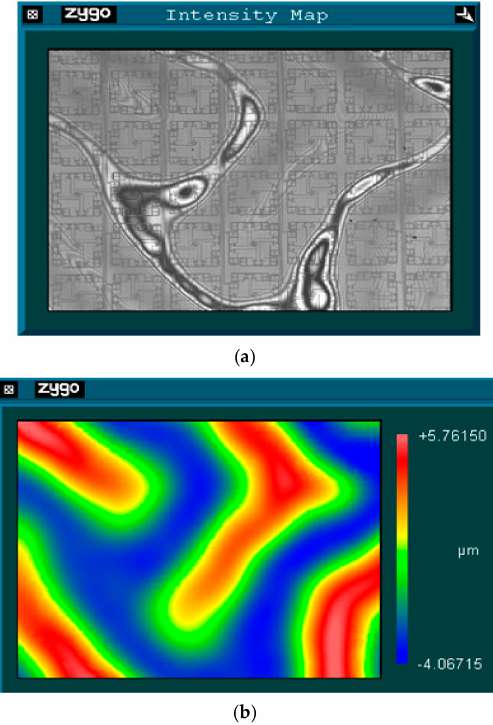
Figure 8. ( a ) Interference pattern of the fabricated mirror in Zygo profiler. ( b ) Surface profile measured by Zygo profiler.